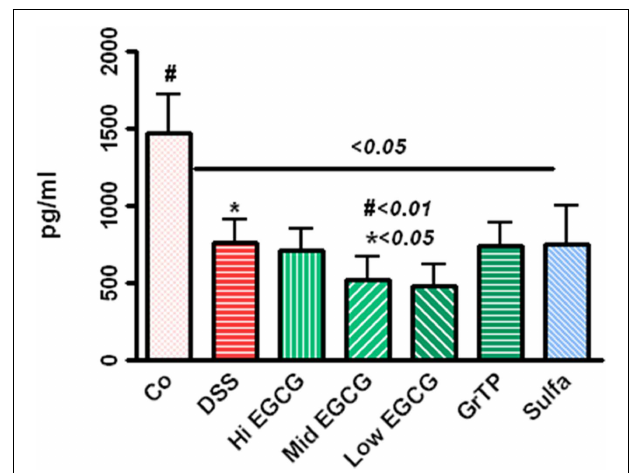
FIGURE 3 | Circulating leptin level significantly decreased in DSS-induced colitic animals ( p < 0.05) and EGCG further reduced the leptin levels (DSS vs. EGCG < 0.05), while GrTP and sulfasalazine had no significant effect on leptin levels (vs. DSS > 0.05) .